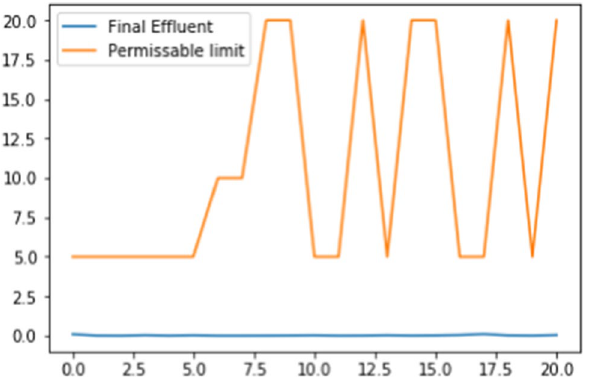
Fig. 11 Final effluent prediction using machine learning against the permissible limits in time-series